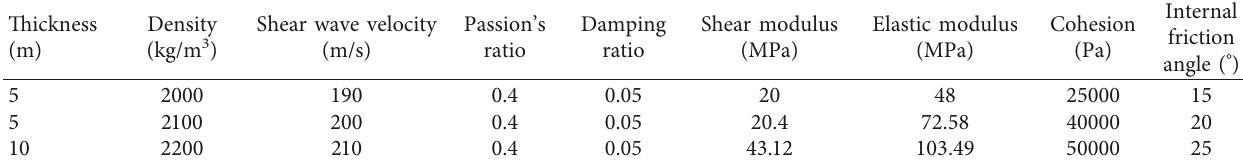
Table 4: Parameters of soil.